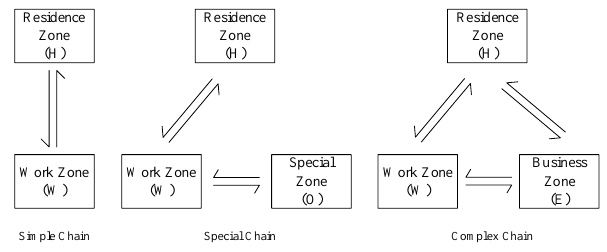
Figure 2. Travel chain of private cars.